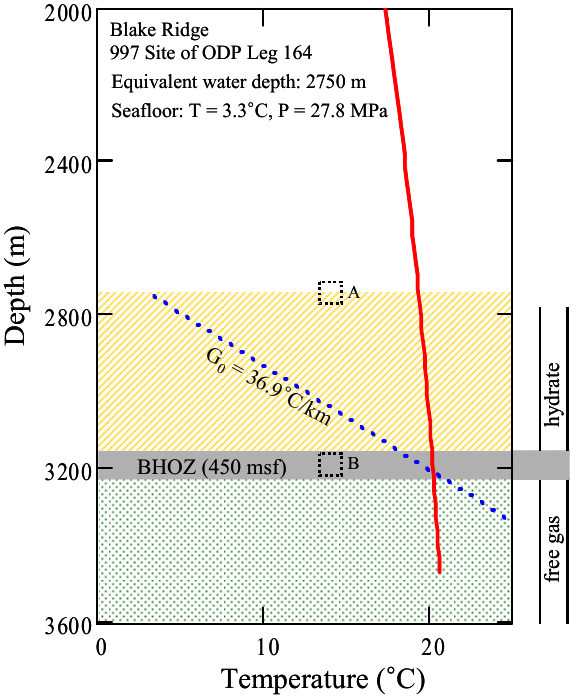
Figure 3. Geological conditions of the reconstructed model site. Note that the BHOZ represents the base of the hydrate occurrence zone and the methane hydrate stability curve is plotted based on the following equation given by Peltzer and Brewer [71]: